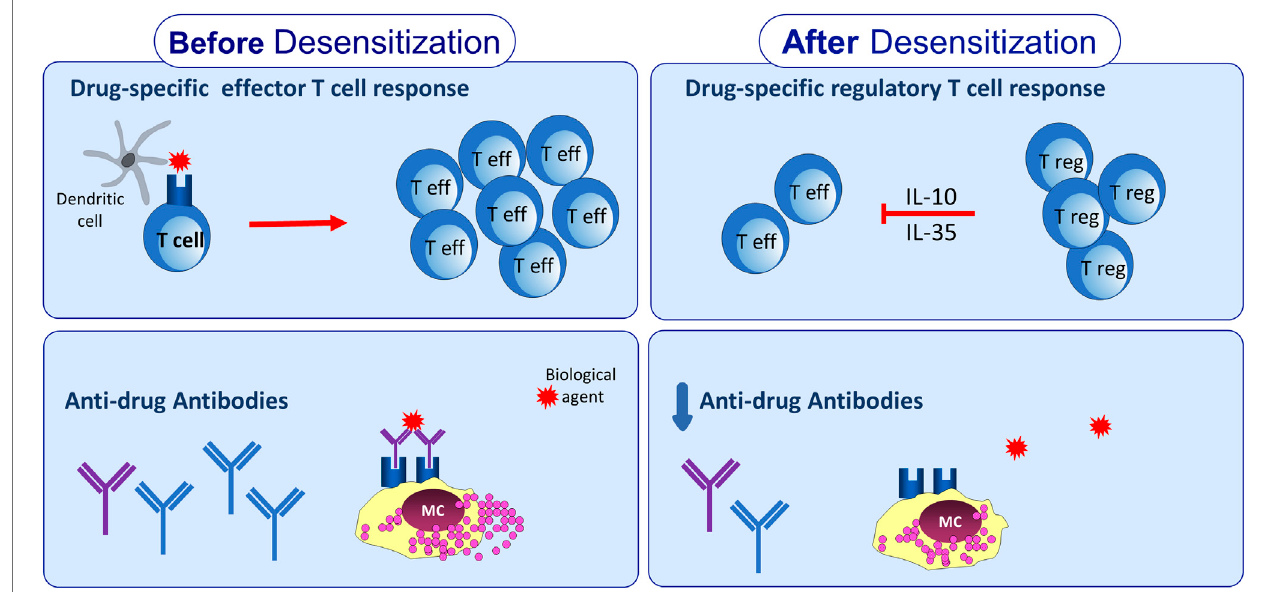
Figure 1 | Adaptive immunological changes induced by drug desensitization. Drug desensitization may impact on adaptiveimmune response leading toreduction of anti-drug antibodies levels. In addition, drug-speci fi c T cell response seems to be affected by drug desensitization, due to expansion of T regulatory cells able to produce IL-10 and